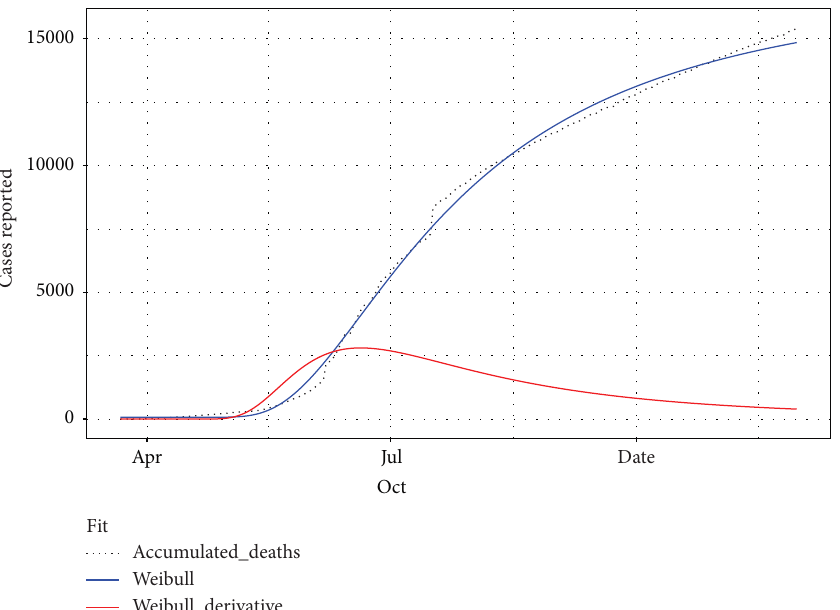
Figure 12: Fit of the Weibull model to the number of deaths accumulated by COVID-19 in Chile (in blue) and ft of the evolution of the number of daily deaths (in red), using data from March 22 to November 30 of 2020.